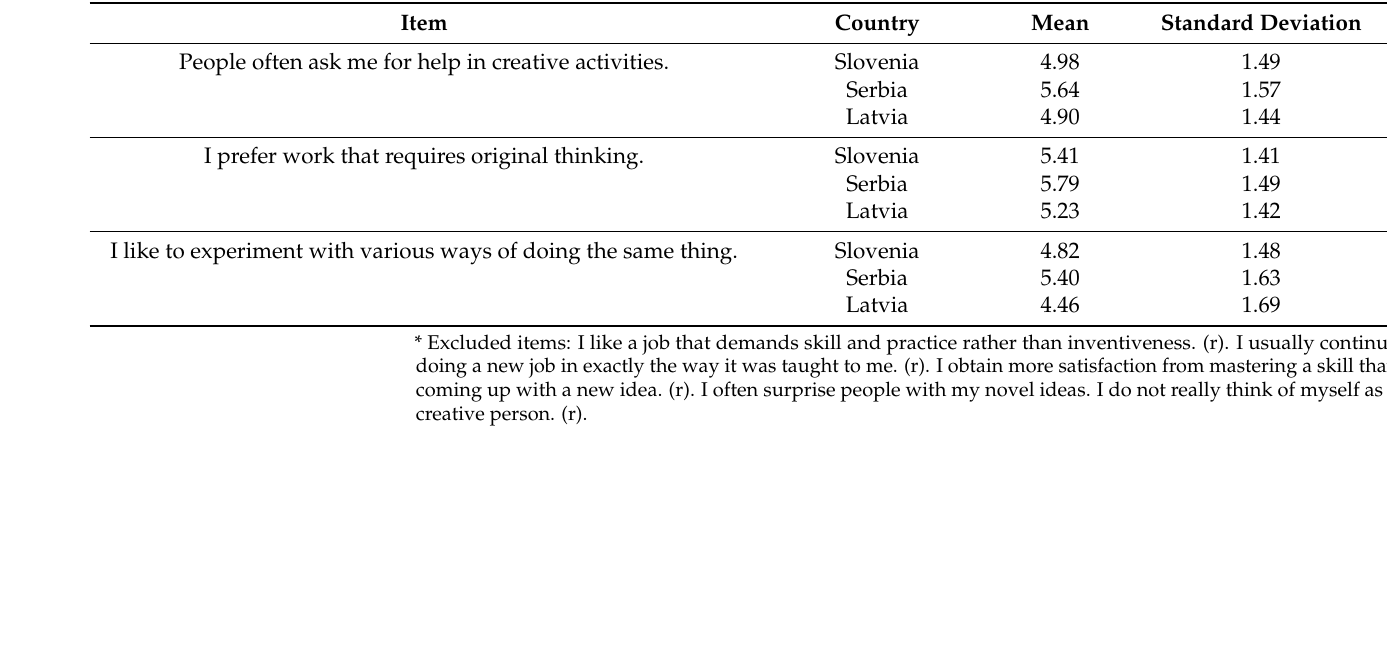
Table A2. Innovativeness of the entrepreneurial items* (Agreement with the statement: 1 = Strongly Disagree, 2 = Moderately Disagree, 3 = Slightly Disagree, 4 = Neither Agree Nor Disagree, 5 = Slightly Agree, 6 = Moderately Agree, 7 = Strongly Agree)